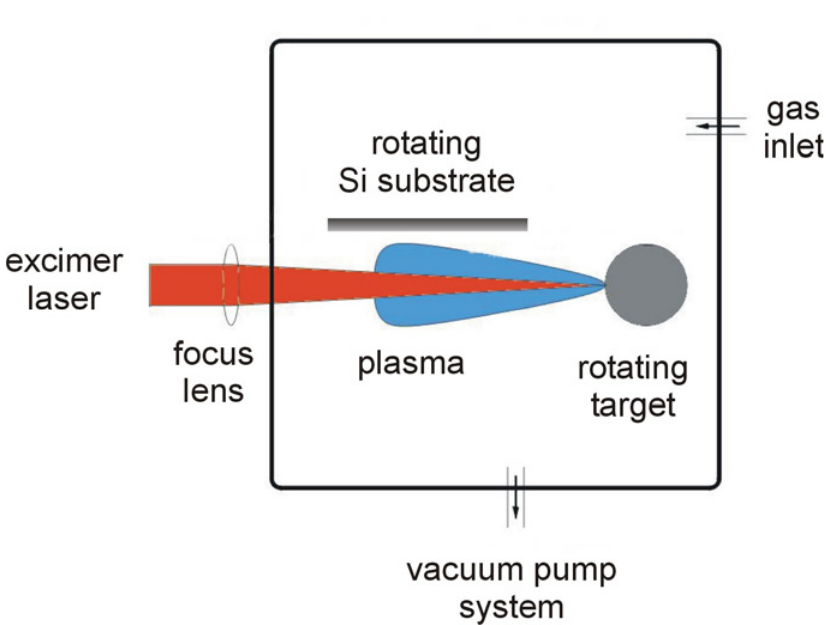
Figure 1. Principle of the off-axis pulsed laser deposition